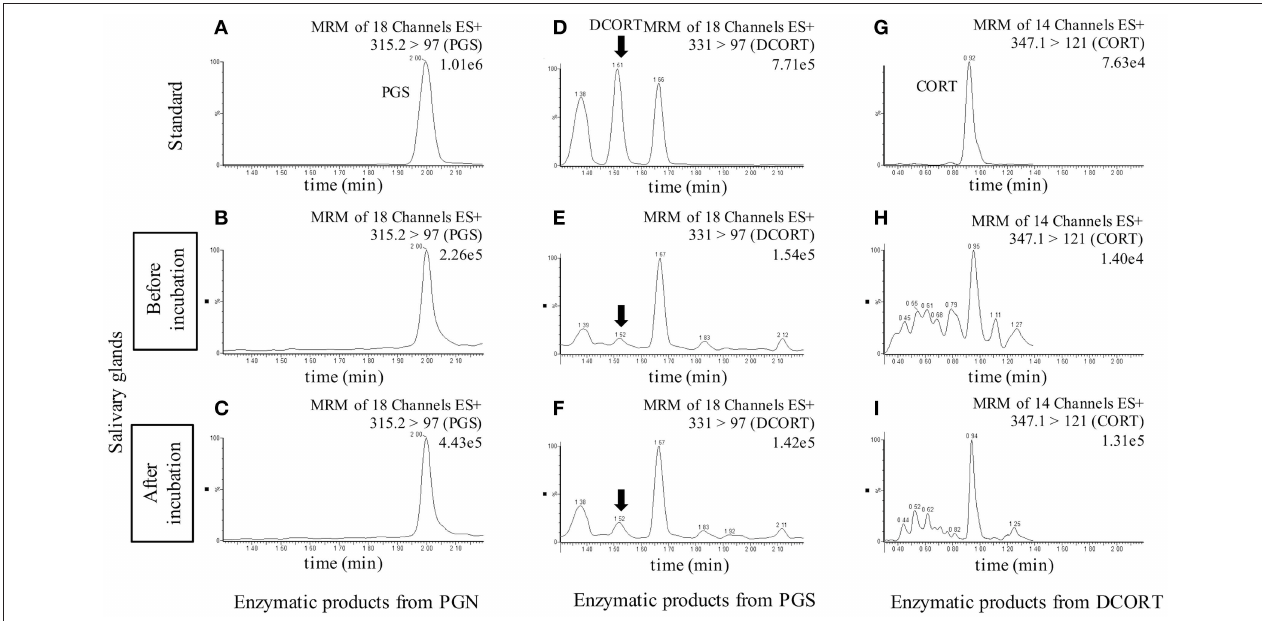
FIGURE 2 | LC-MS analysis of enzymatic products. Chromatograms of standards and exogenous steroids in salivary glands are shown. Values to the upper right of the chromatograms indicate the precursor ion, product ion, and most intense peak (set at 100%). Top: Panels (A,D,G) are showing the chromatograms of the standards of each steroid (10 ng/mL), progesterone (PGS), deoxycorticosterone (DCORT), and corticosterone (CORT), respectively. Middle: Panels (B,E,H) are showing the chromatograms of the incubation mixtures added with pregnenolone (PGN), PGS, and DCORT before incubation, respectively. Bottom: Panels (C,F,I) are showing the chromatograms of the reaction mixtures added with PGN, PGS, and DCORT after a 2-h incubation, respectively. In the DCORT chromatogram, multiple peaks were confirmed, and black arrows indicate DCORT. MRM, multiple reaction monitoring. The intensity of the CORT peak with a retention time of 0.92-0.95 min after the enzyme reaction (I, 1.31e5) was 9.36-fold higher than that of the peak before incubation (H, 1.40e4). Each steroid was analyzed three times in each sample, and representative results are